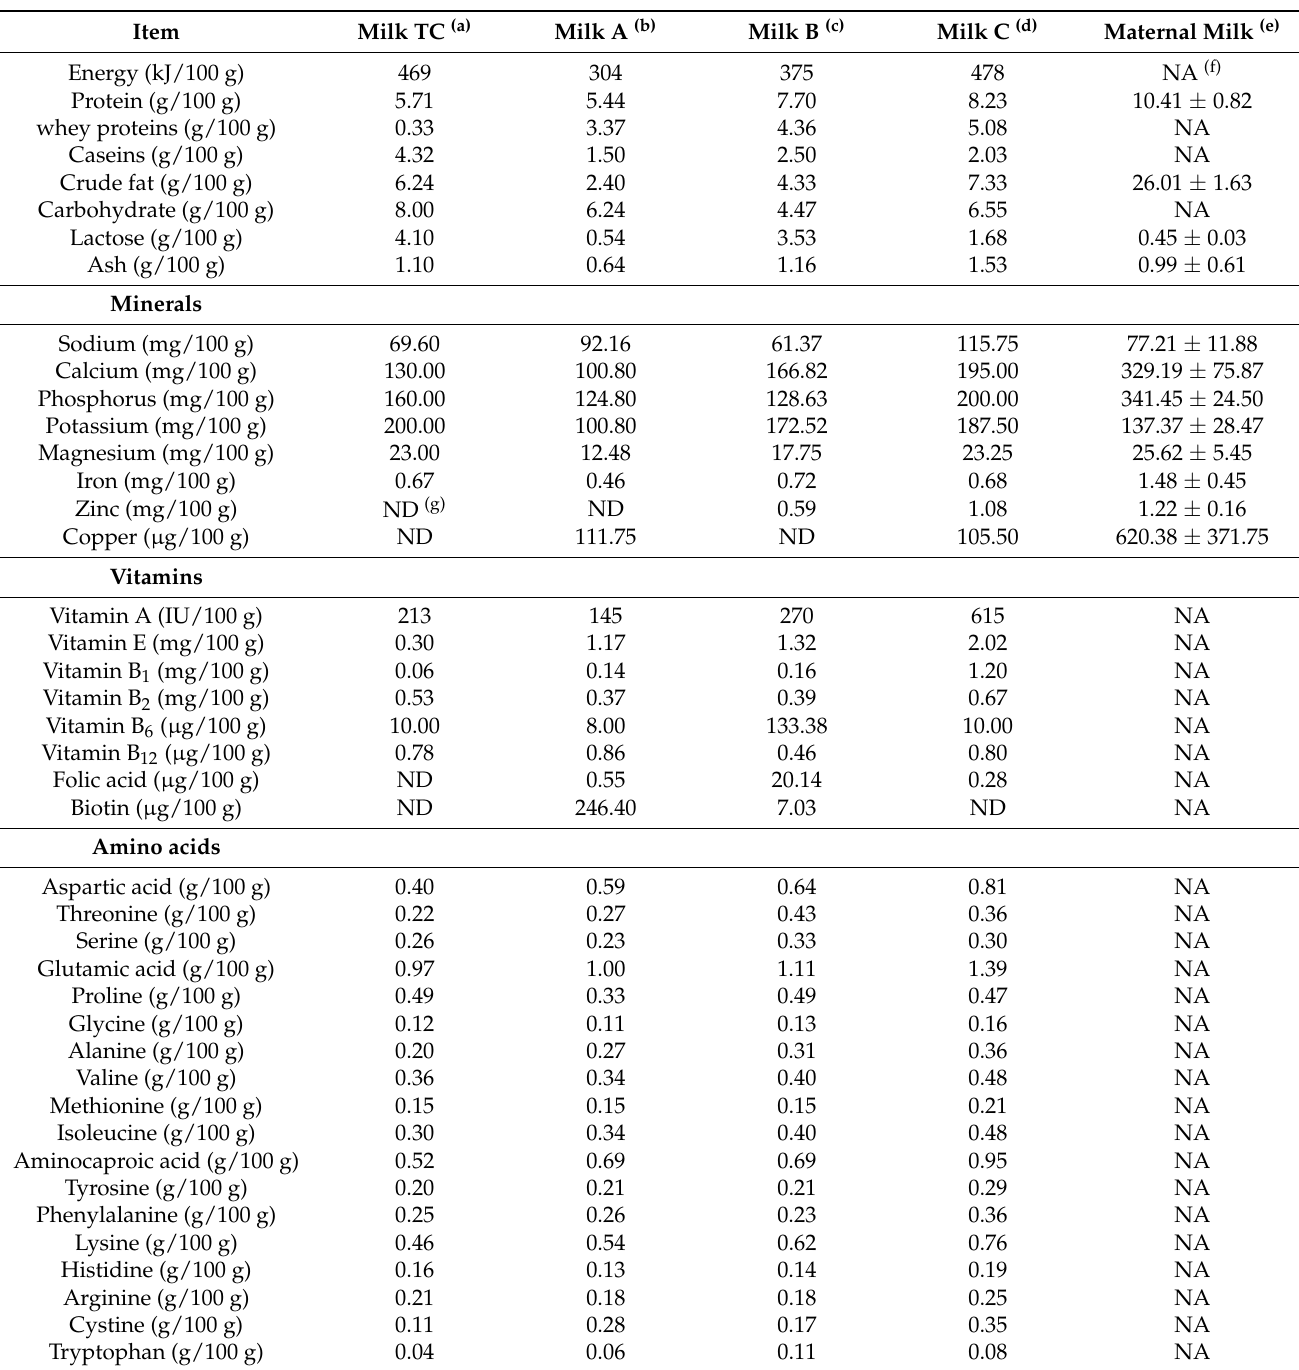
Table 1. Chemical components of different milk substitutes and maternal